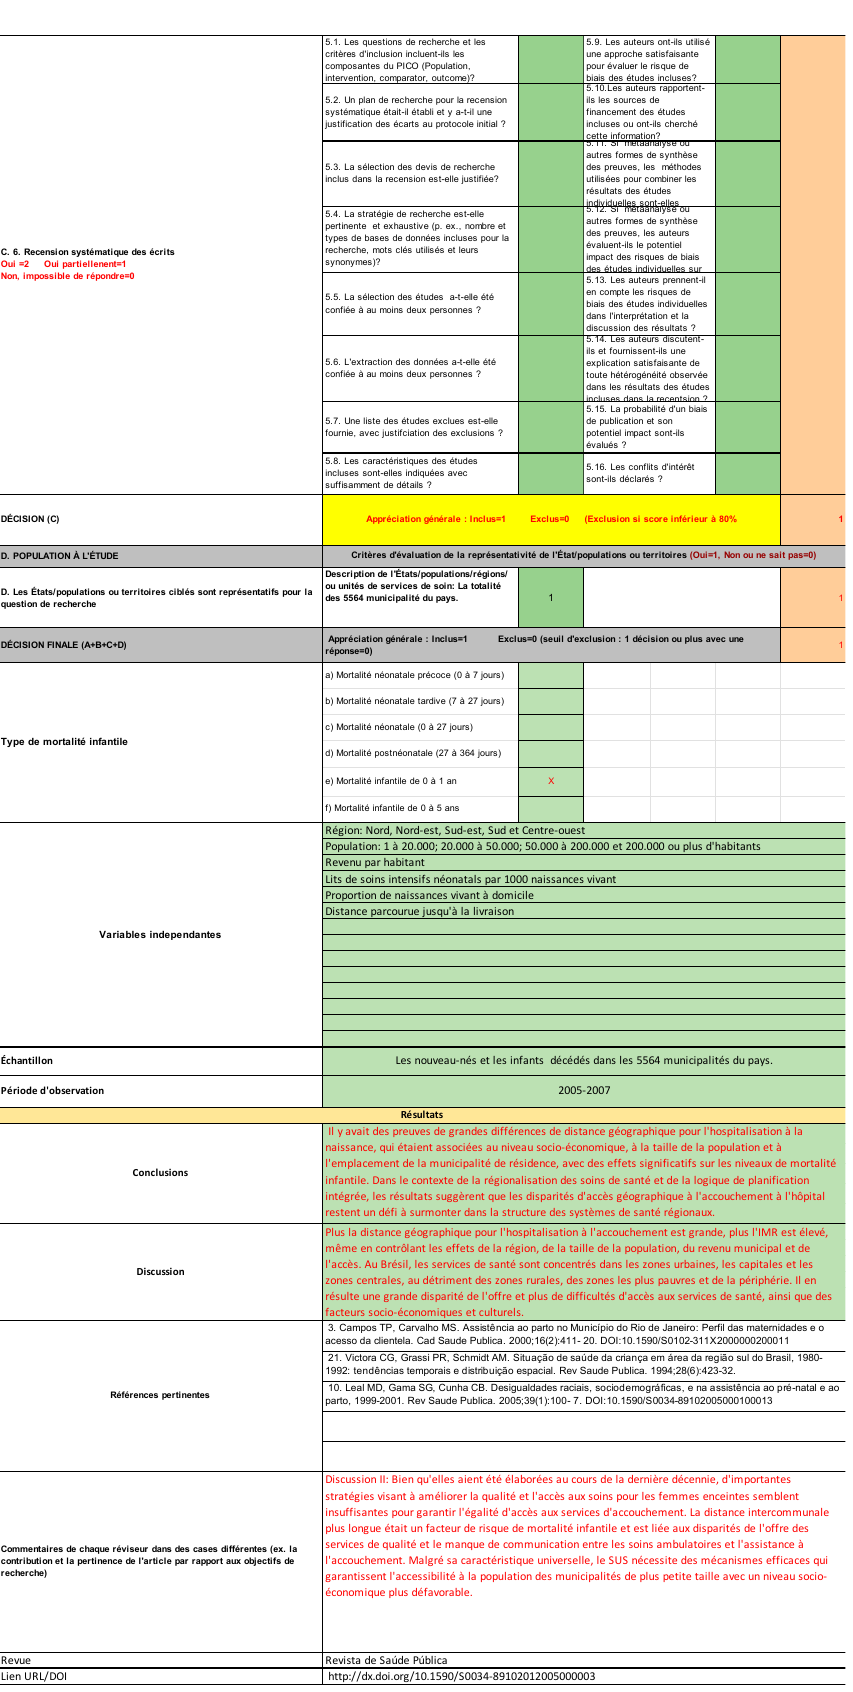
Figure A5. Adapted Mixed Methods Appraisal Tool (MMAT) reading review grid.